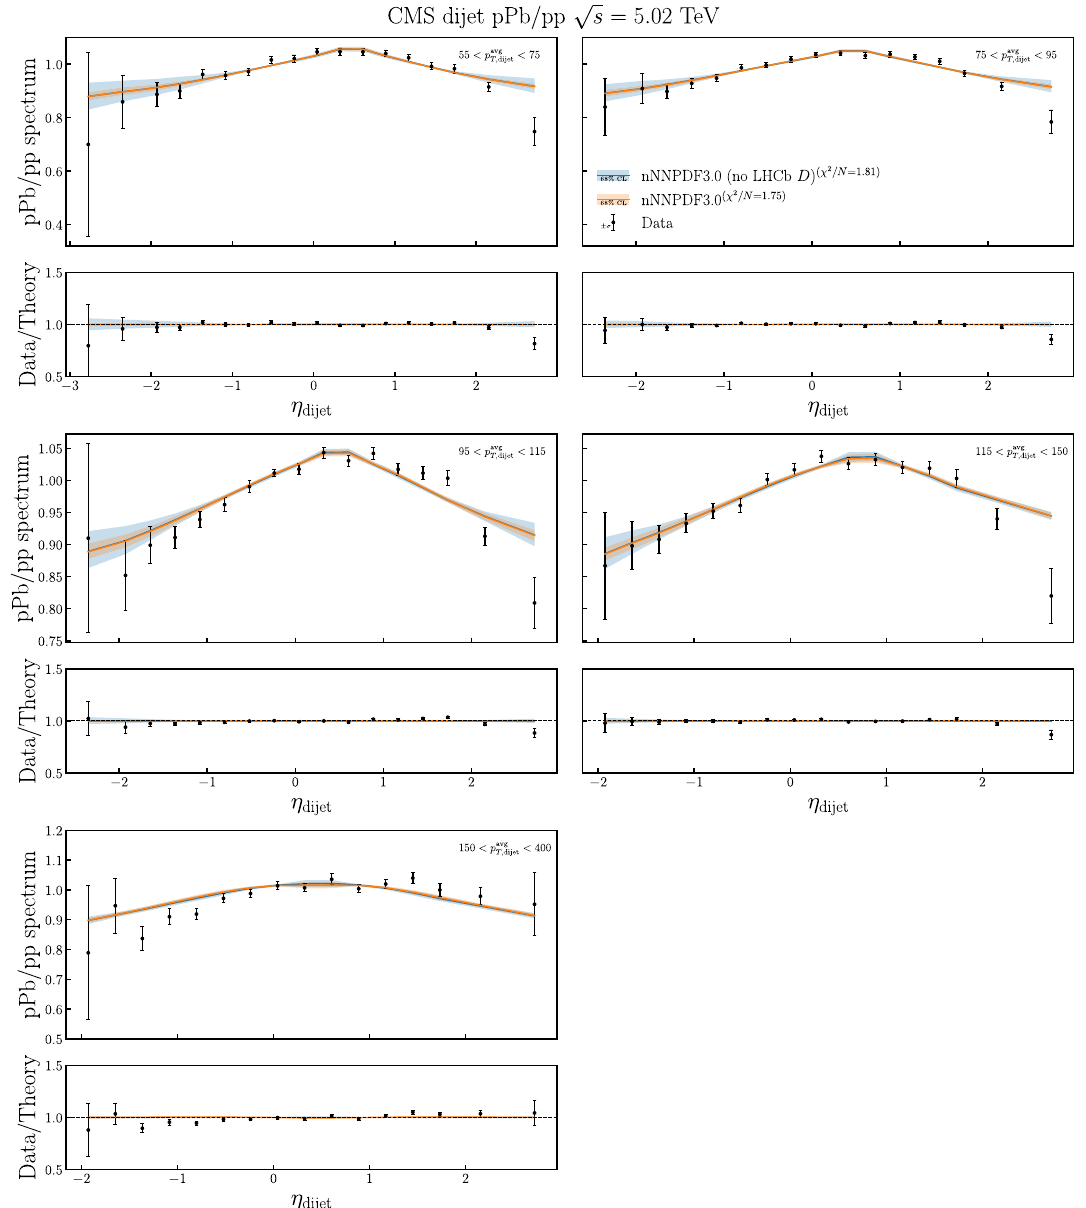
Fig. 34 Same as Fig. 31 for the CMS measurements of dijet production in proton-lead collisions at 5.02 TeV, presented in terms of the ratio between pPb and pp spectra